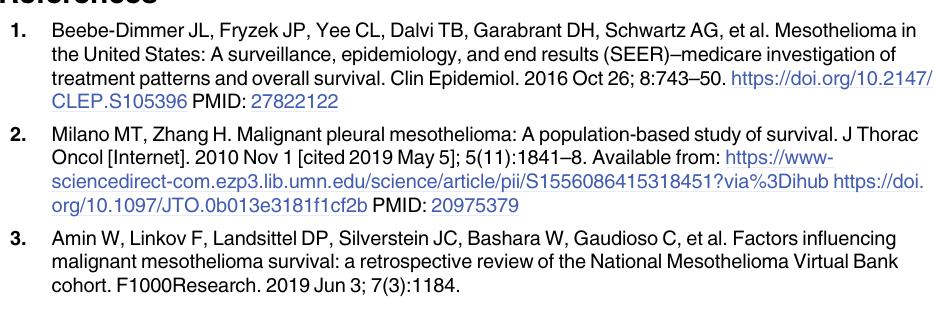
S2 Fig. HCMV IgG status and mesothelioma patient survival. Positive HCMV IgG status, indicating the presence of HCMV antibodies, was associated with lower survival when com- pared to those with negative HCMV IgG status. This association was not found to be statisti- cally significant (p =